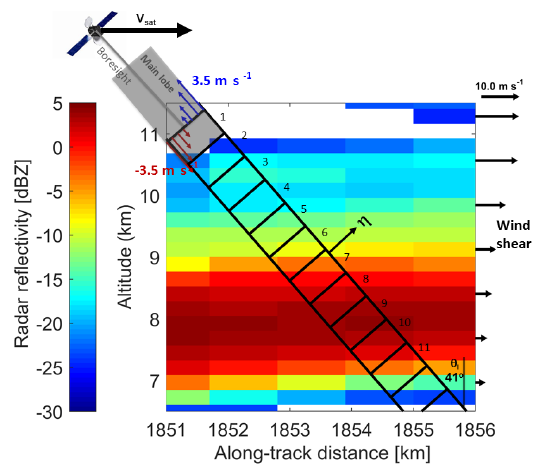
Figure 7. Diagram explaining Doppler velocity errors introduced by NUBF. The reflectivity profiles are extracted from Hurricane Igor (ice clouds corresponding to the red arrow in the left panel of Fig. 3). The black rectangles represent the backscattering volumes associated with the 3dB antenna main